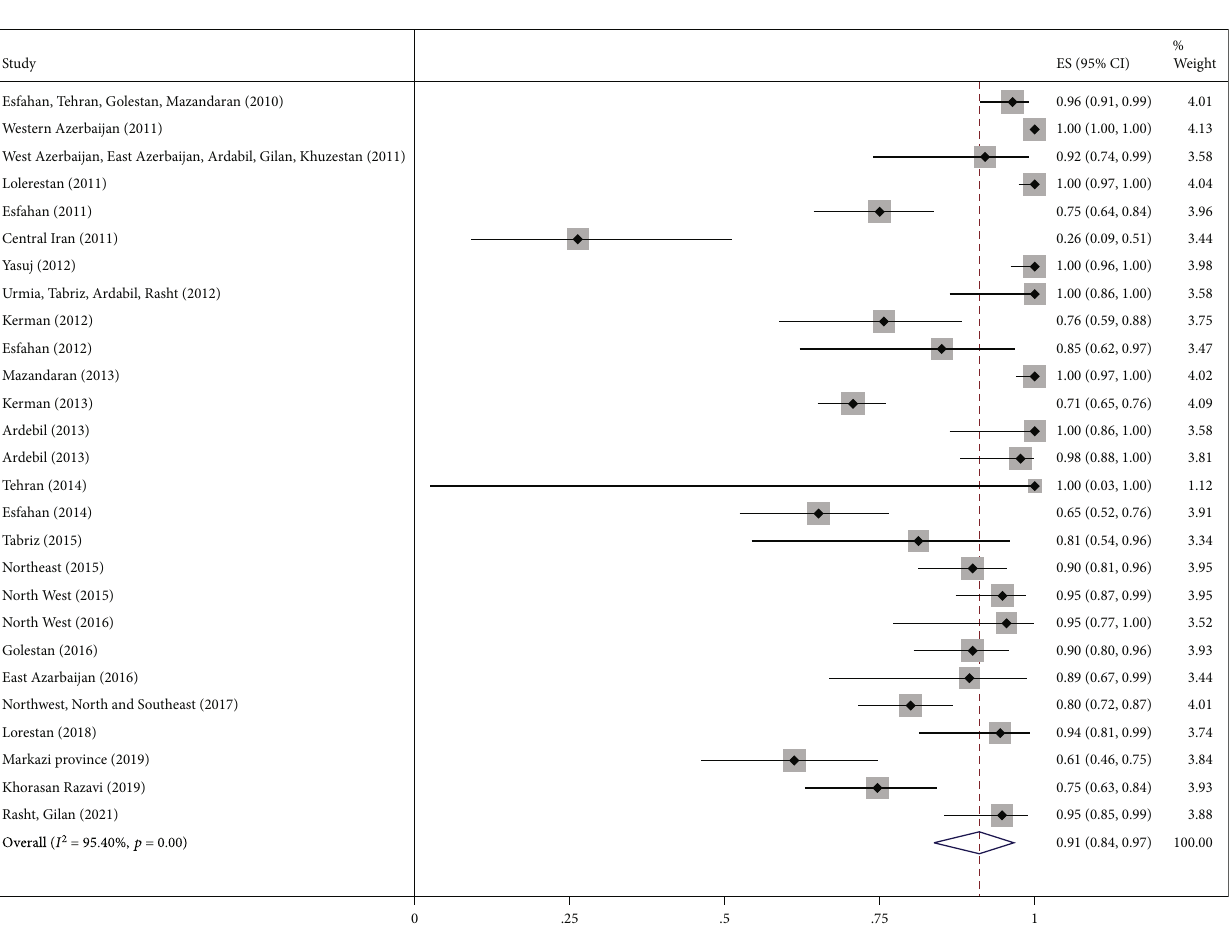
Figure 4: Forest plot of 27 studies on cystic echinococcosis G